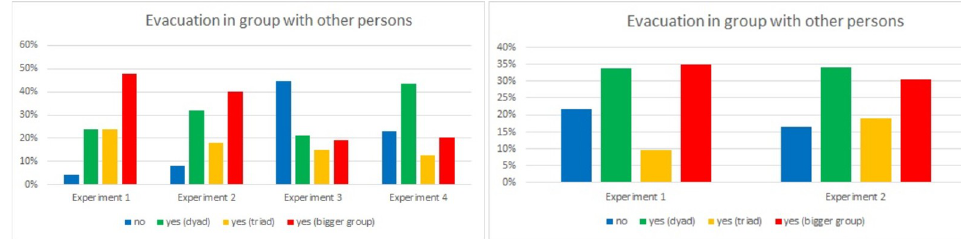
Fig 15. Grouping behavior during consecutive experiments—question 6. (Results from Laliki experiment are on the left; results from Gda ń sk on the right).